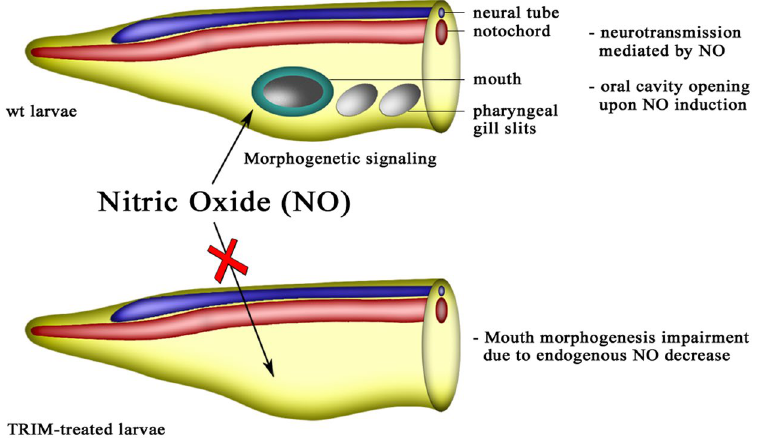
Figure 5. Nitric Oxide role during amphioxus larval development. Schematic representation of the rostral part of amphioxus larvae indicates possible involvement of NO in mouth development. The conspicuous depletion of endogenous NO by NOS inhibition (TRIM-treated larvae) leads to an abnormal phenotype without a